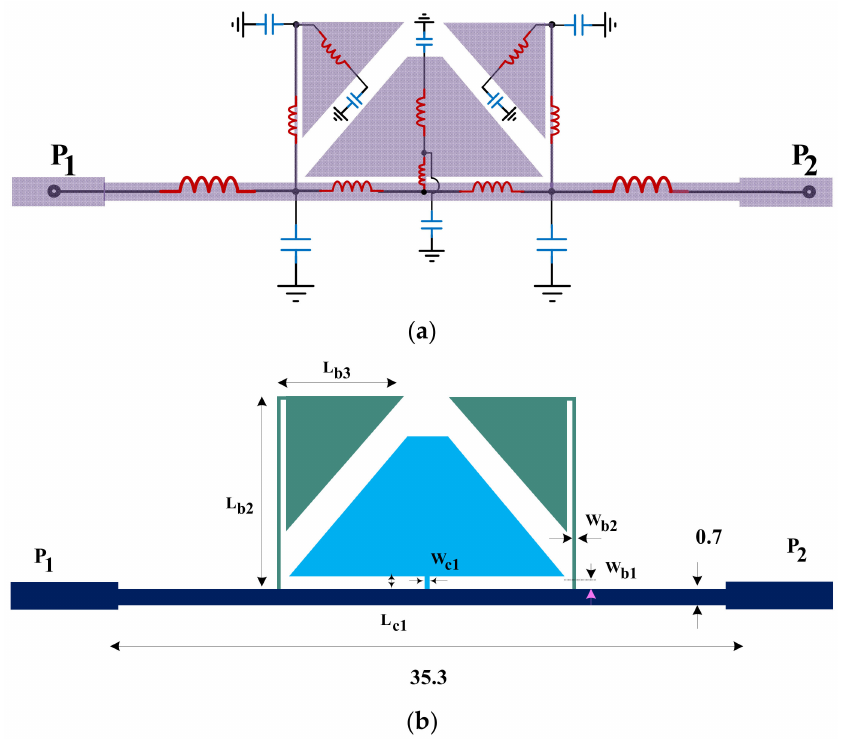
Figure 10. Layout of the proposed horizontal resonator. ( a ) Layout extraction of the resonator from the LC equivalent circuit. ( b ) Dimensions of the proposed horizontal resonator.